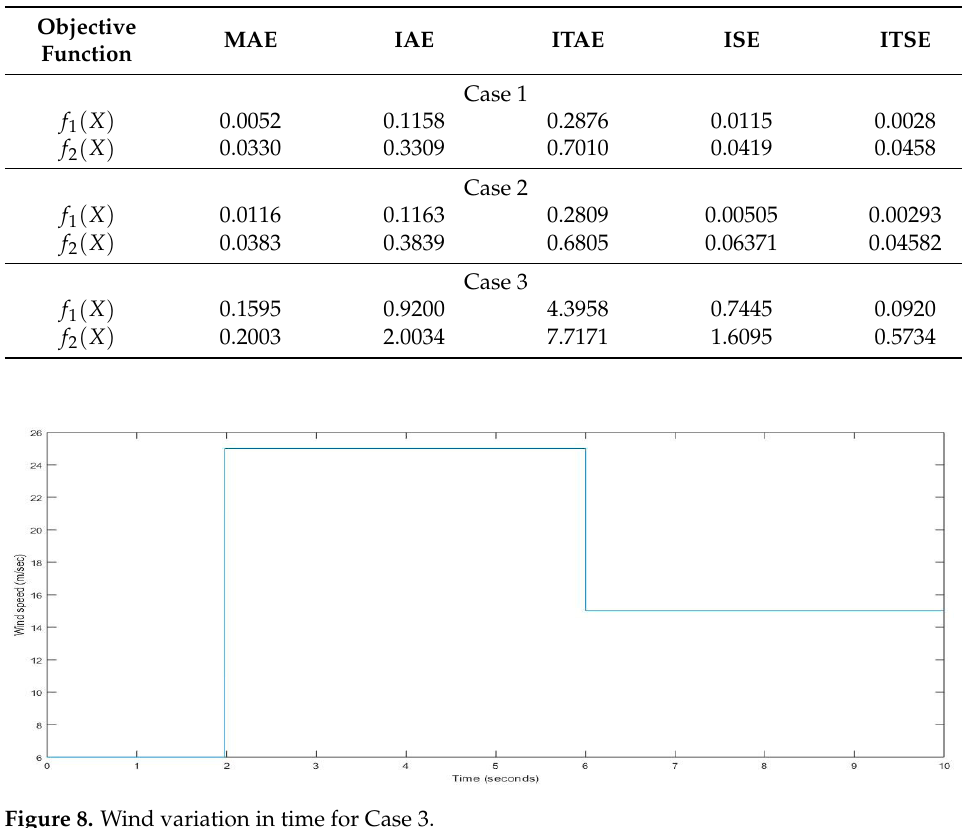
Table 3. Performance evaluation based on different error criteria.